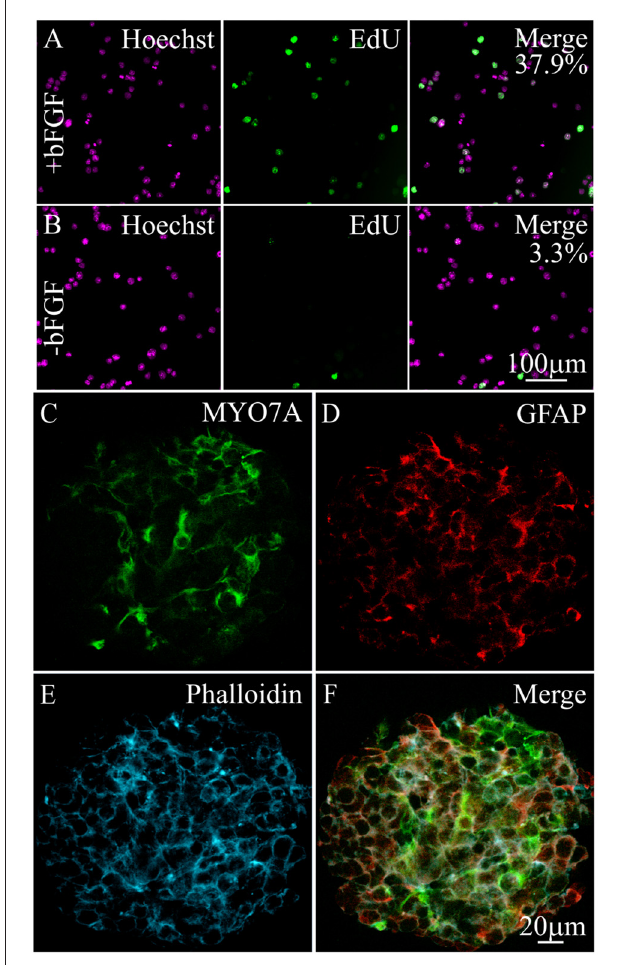
FIGURE 1 | Expression of hair cell and supporting cell markers in differentiating immortalized multipotent otic progenitor (iMOP) cells. Proliferating iMOP cells cultured in basic fibroblast growth factor (bFGF) were subjected to 5-ethynyl-2’-deoxyuridine (EdU) incorporation. (A) Hoechst labeled nuclei from proliferating iMOP cells show EdU incorporation in 37.9% of cells ( n = 3). (B) Hoechst labeled nuclei from differentiating iMOP cells showed EdU incorporation in 3.3% of cells ( n = 3). Differentiating iMOP cells express (C) MYO7A and (D) glial fibrillary acidic protein (GFAP) in (E) phalloidin marked otospheres. (F) Otospheres from differentiating iMOP cultures were used to test for the effects of cisplatin